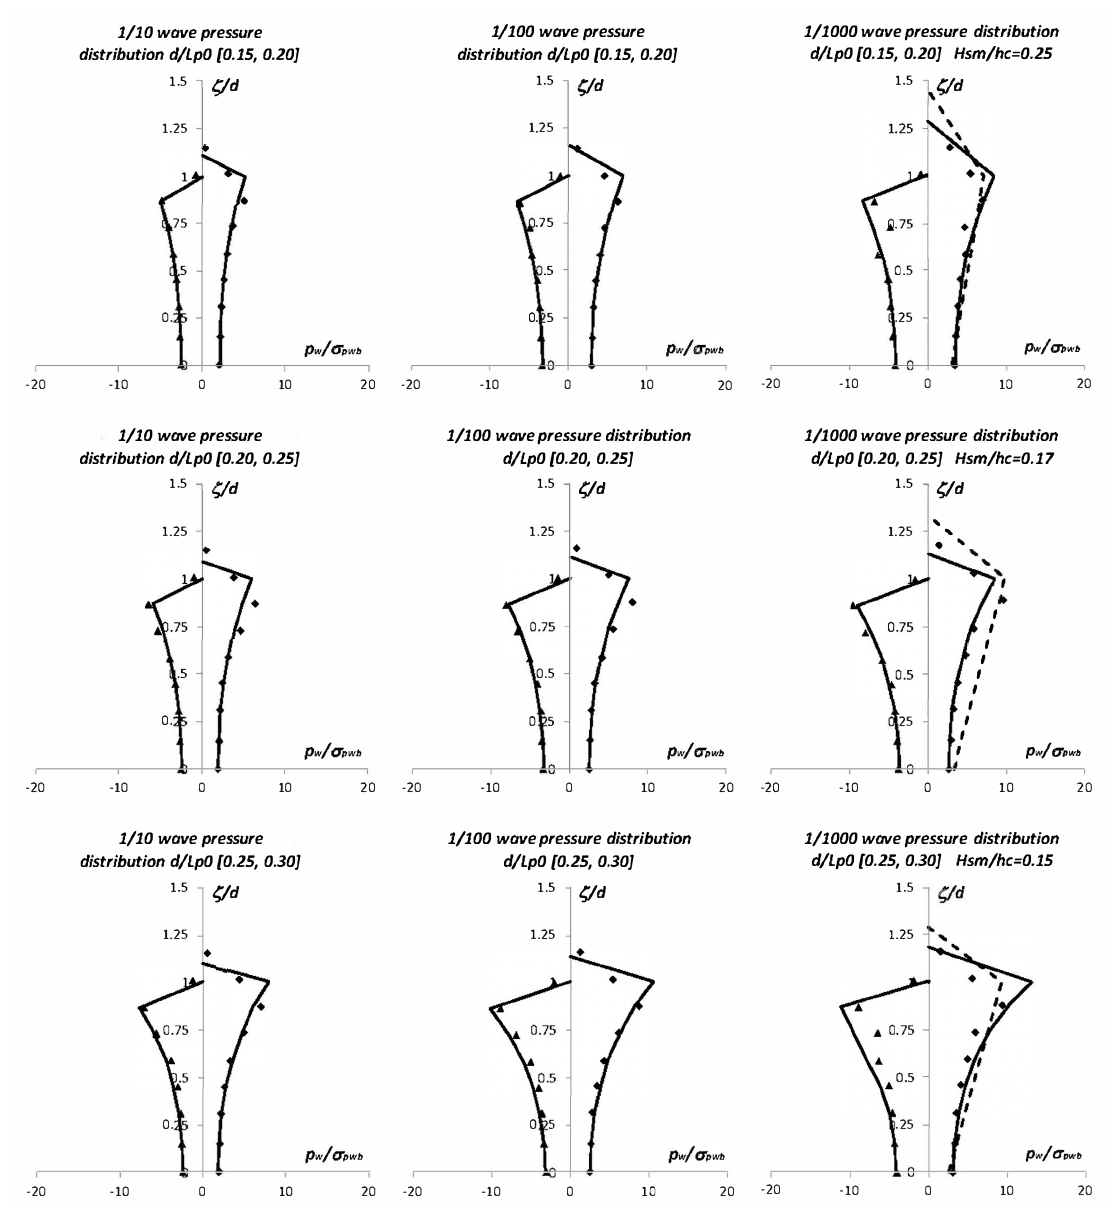
Figure 6. Average of the highest 1/10, 1/100 and 1/1000 wave pressure distribution (crests and troughs) of sea states constituted by wind waves in fixed intervals of d / L p 0 (see Table 1). Points represents experimental results, the continuous lines and the dotted line represent the pressure distribution obtained by means of Boccotti’s and Goda’s formulas,